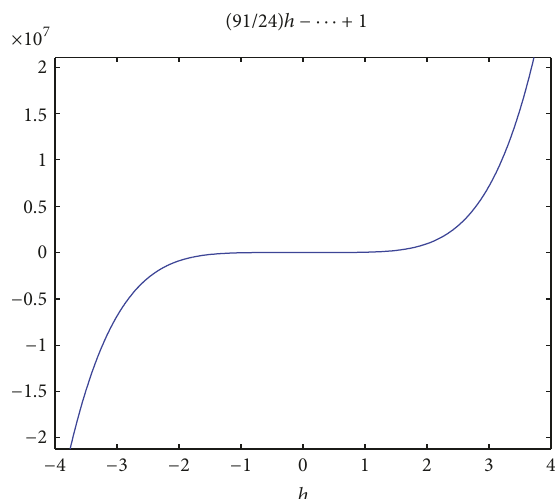
Figure 1: The ℎ -curves obtained from the 6-order HAM approxi- mate solution for Fabrizio-Caputo logistic